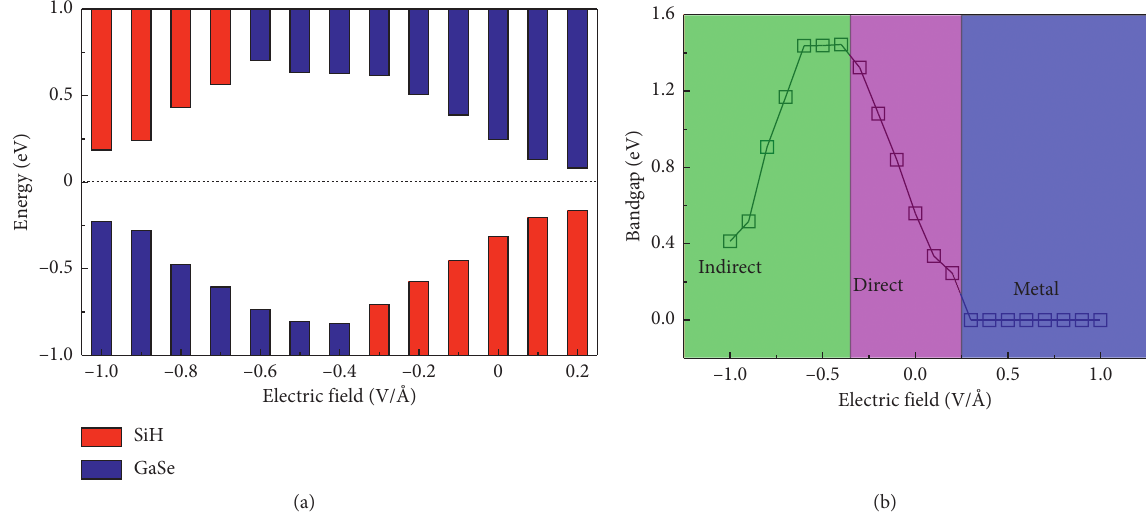
Figure 3: The (a) band edge and (b) band gap as a function of the external external field strength in the GaSe/SiH vdW heterostructure.